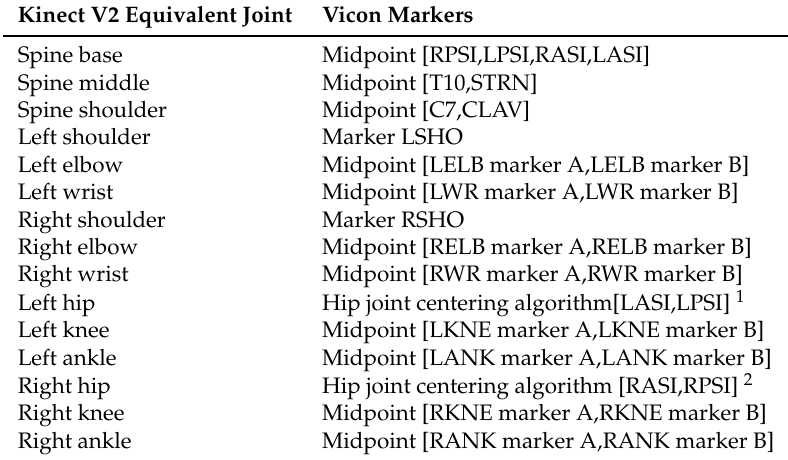
Table 1. Mapping rules to build the equivalent Kinect V2 skeleton.